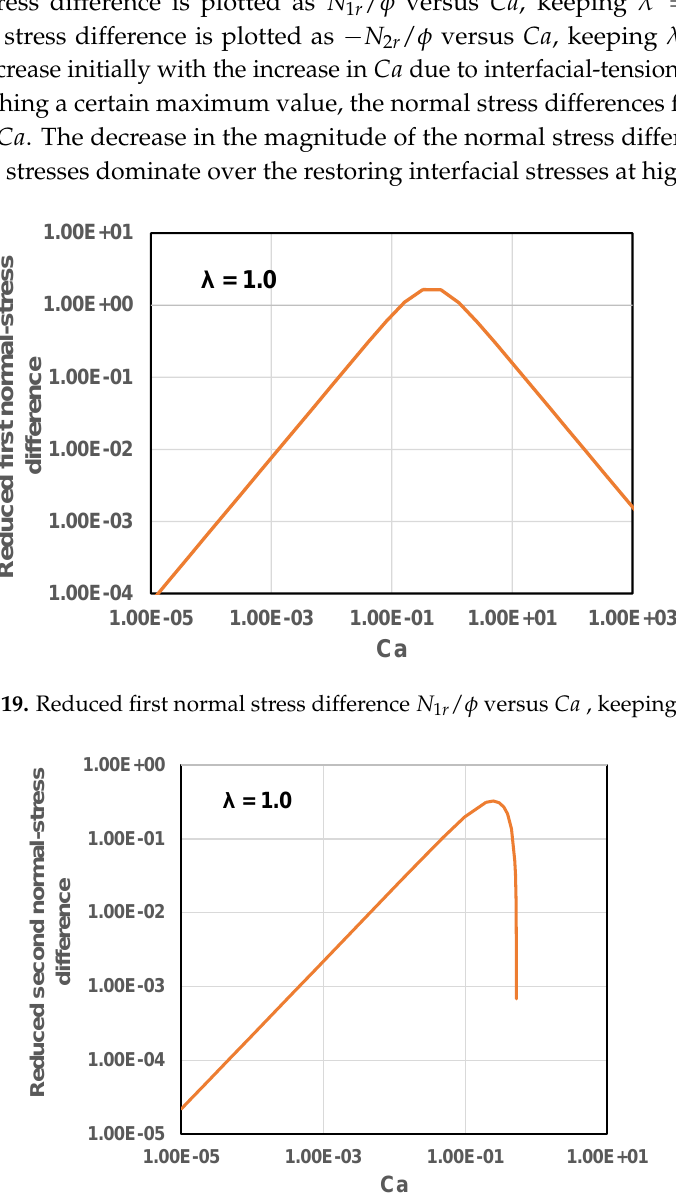
Figure 20. Reduced second normal stress difference − N 2 r / φ versus Ca , keeping λ =